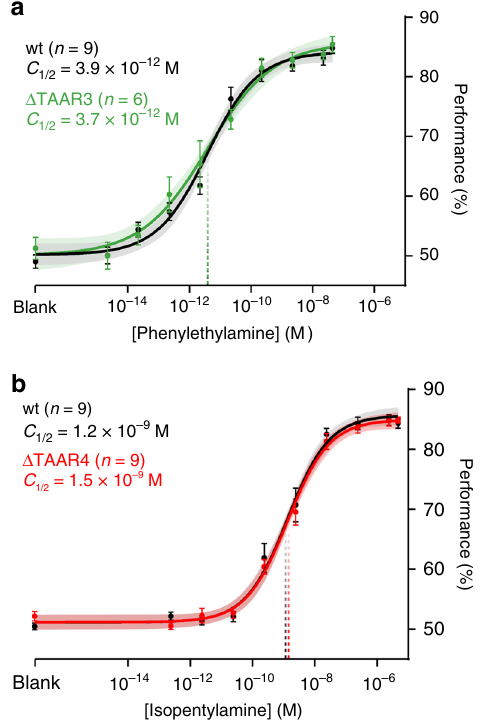
Fig. 5 Deletion of single TAARs does not impact sensitivity to non- preferred ligands. a Psychometric curves of wild-type (black) and TAAR4 deletion littermates (red) to isopentylamine. b Psychometric curves of wild- type (black) and TAAR3 deletion littermates (green) to phenylethylamine. Plots show mean + / − SE with a shaded 95% con fi dence interval. Data were fi tted using a Hill function. Behavioral sensitivity is de fi ned as the odor concentration at half-maximal behavioral performance ( C ½ ) during a head- fi xed Go/No-Go conditioned assay. Phenylethylamine: wt C ½ = 3.9 × 10 − 12 M (95% CI = 2.0 – 7.1 × 10 − 12 ); Δ T3 C ½ = 3.7 × 10 − 12 M (95% CI = 1.1 – 12.5 × 10 − 12 ). Isopentylamine: wt C ½ = 1.2 × 10 − 9 M (95% CI = 0.6 – 1.9 × 10 − 9 M); Δ T4 C ½ = 1.5 × 10 − 9 M (95% CI 0.9 – 2.3 × 10 − 9 M)